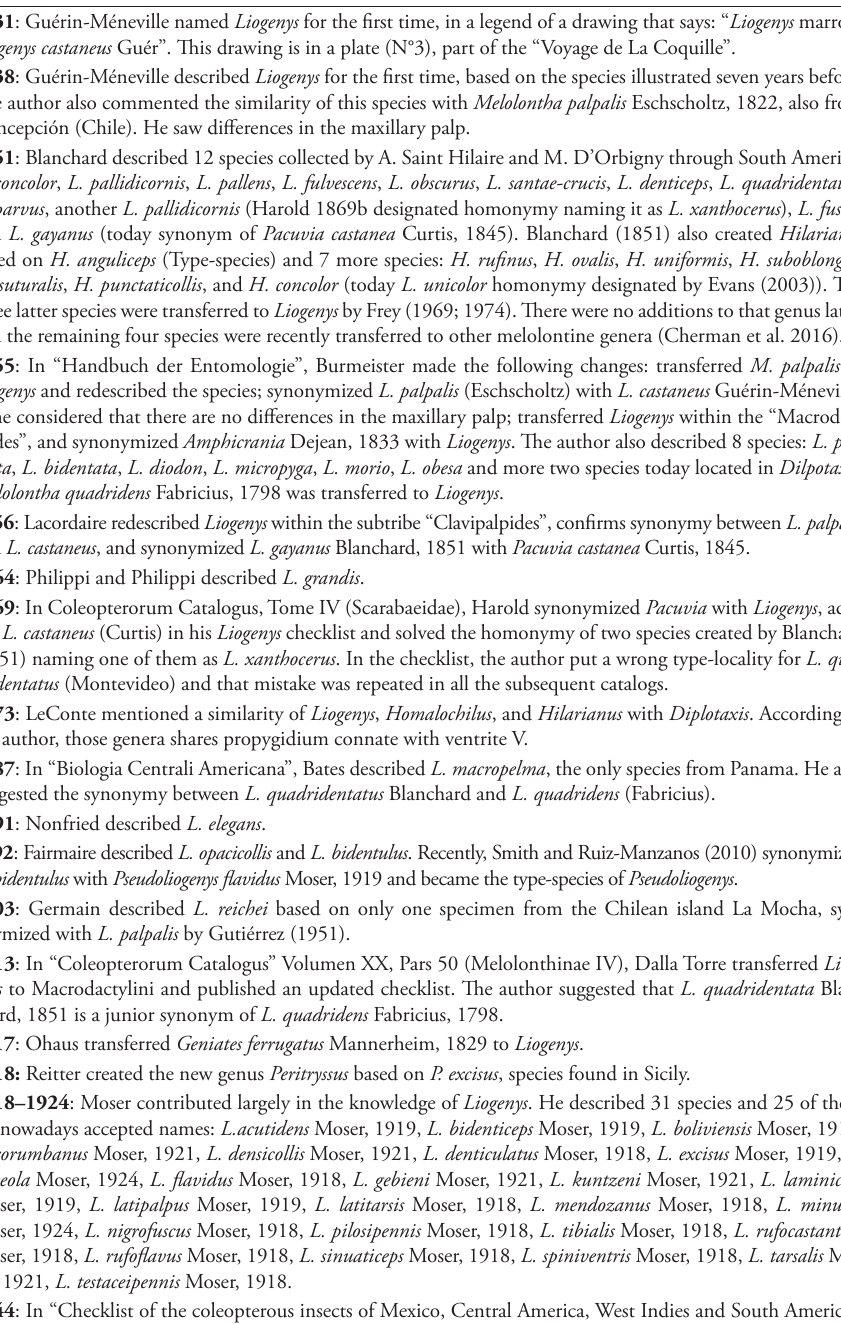
Table 1. History of Liogenys